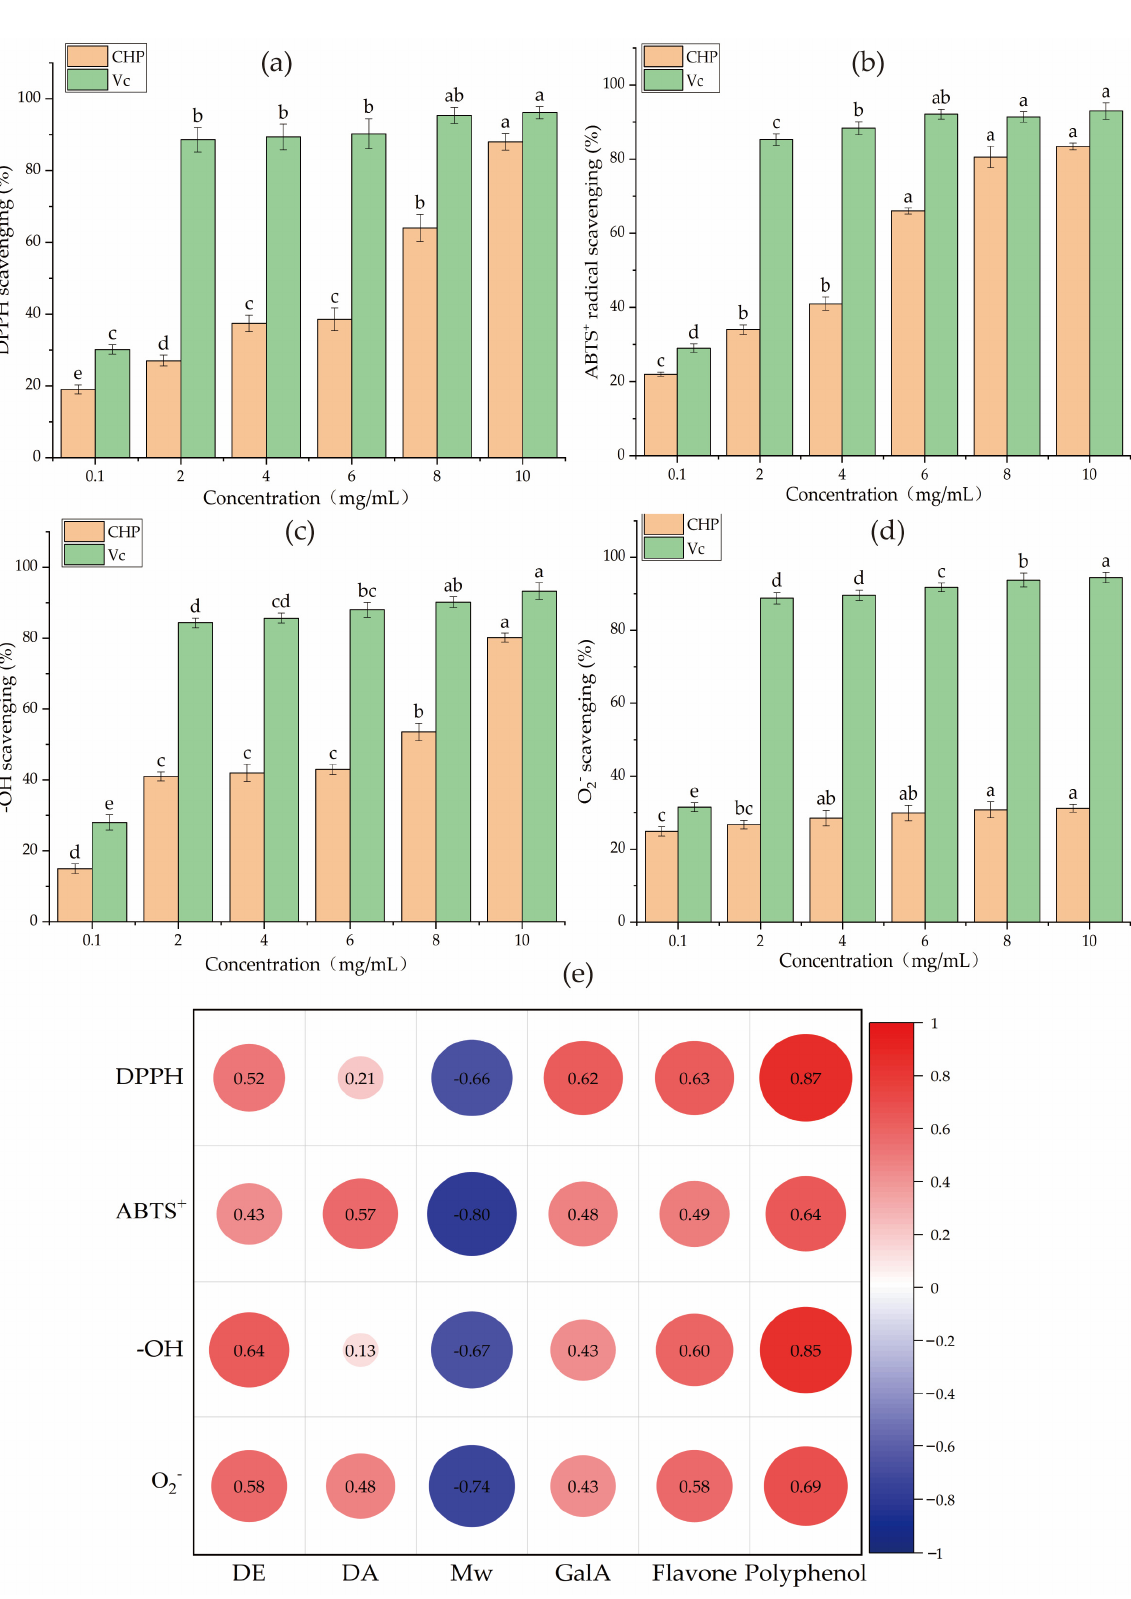
Figure 4. The antioxidant capacity of CHP; ( a – d ) represent the scavenging ability of CHP to DPPH, ABTS + , hydroxyl radical, and superoxide radical, respectively, different letters on the bars represent the significant differences ( p < 0.05); ( e ) represents the correlation among DE, DA, Mw, GalA, polyphe- nols, flavonoids, DPPH, ABTS + , hydroxyl radical, and superoxide radical scavenging